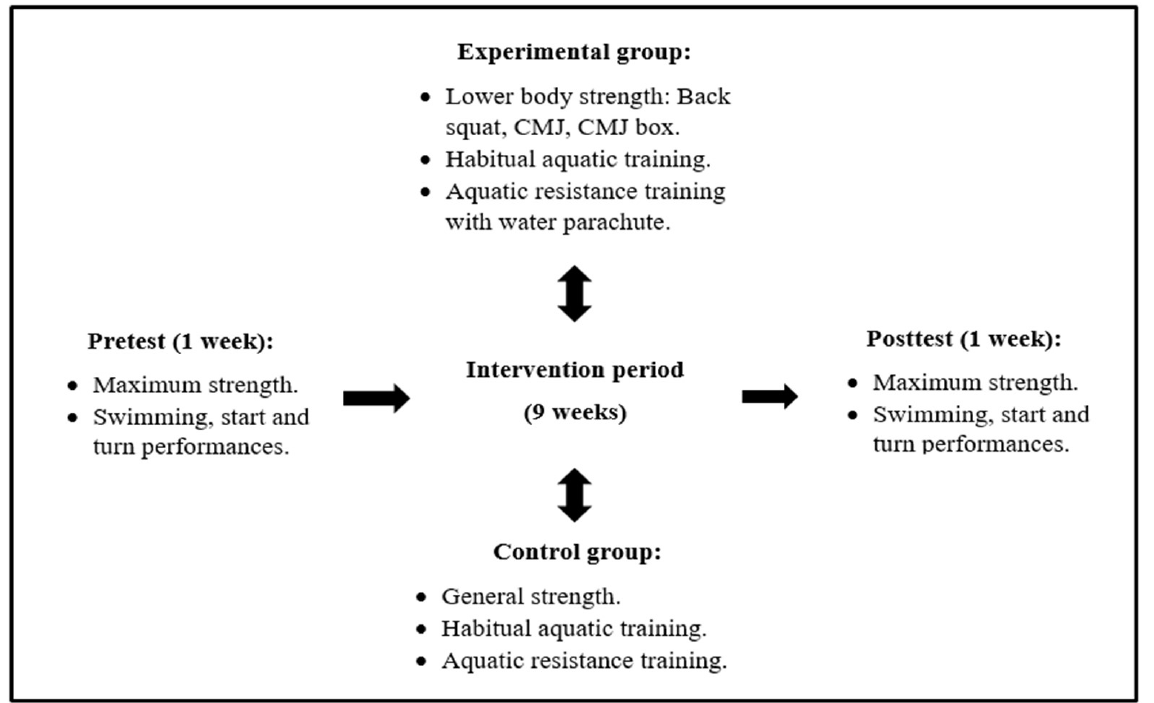
Figure 1. Overview of the study design. CMJ: countermovement jump; CMJ box: countermovement jump box.